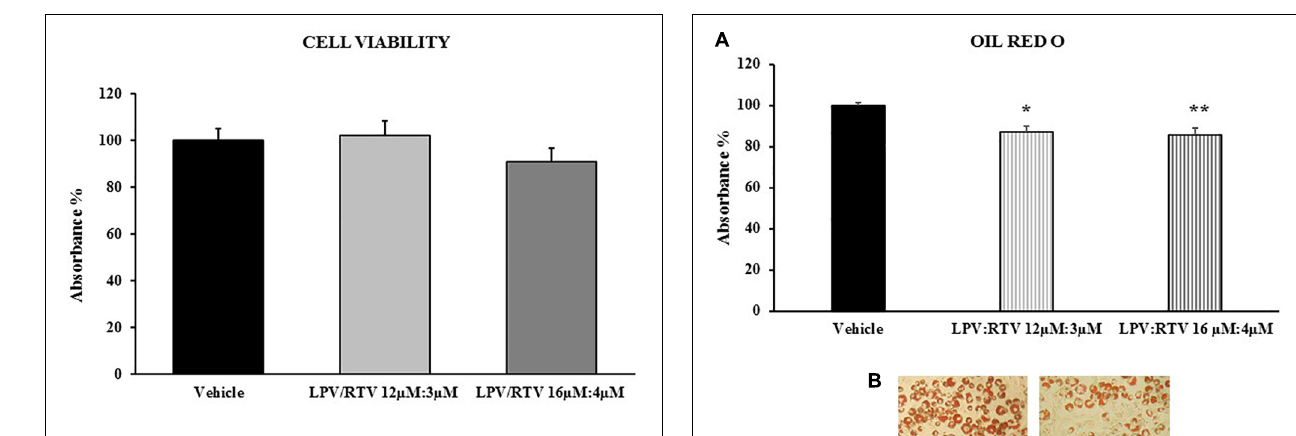
for 12 µ M:3 µ M and − 57% for 16 µ M:4 µ M; respectively, p < 0.01 and p < 0.05 vs. vehicle) ( Figure 3C